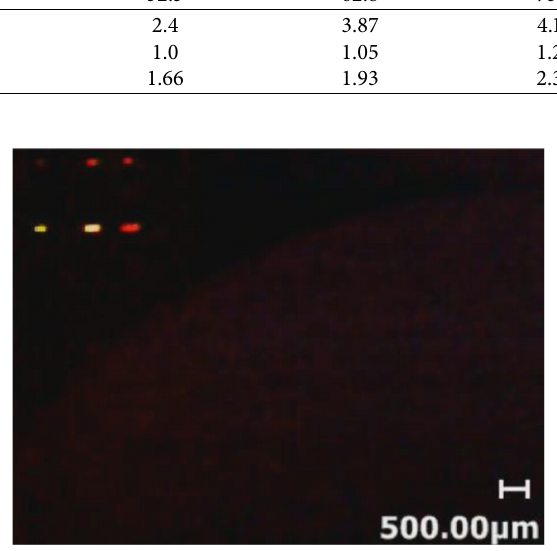
Figure 9: The spark flight path of Cu.